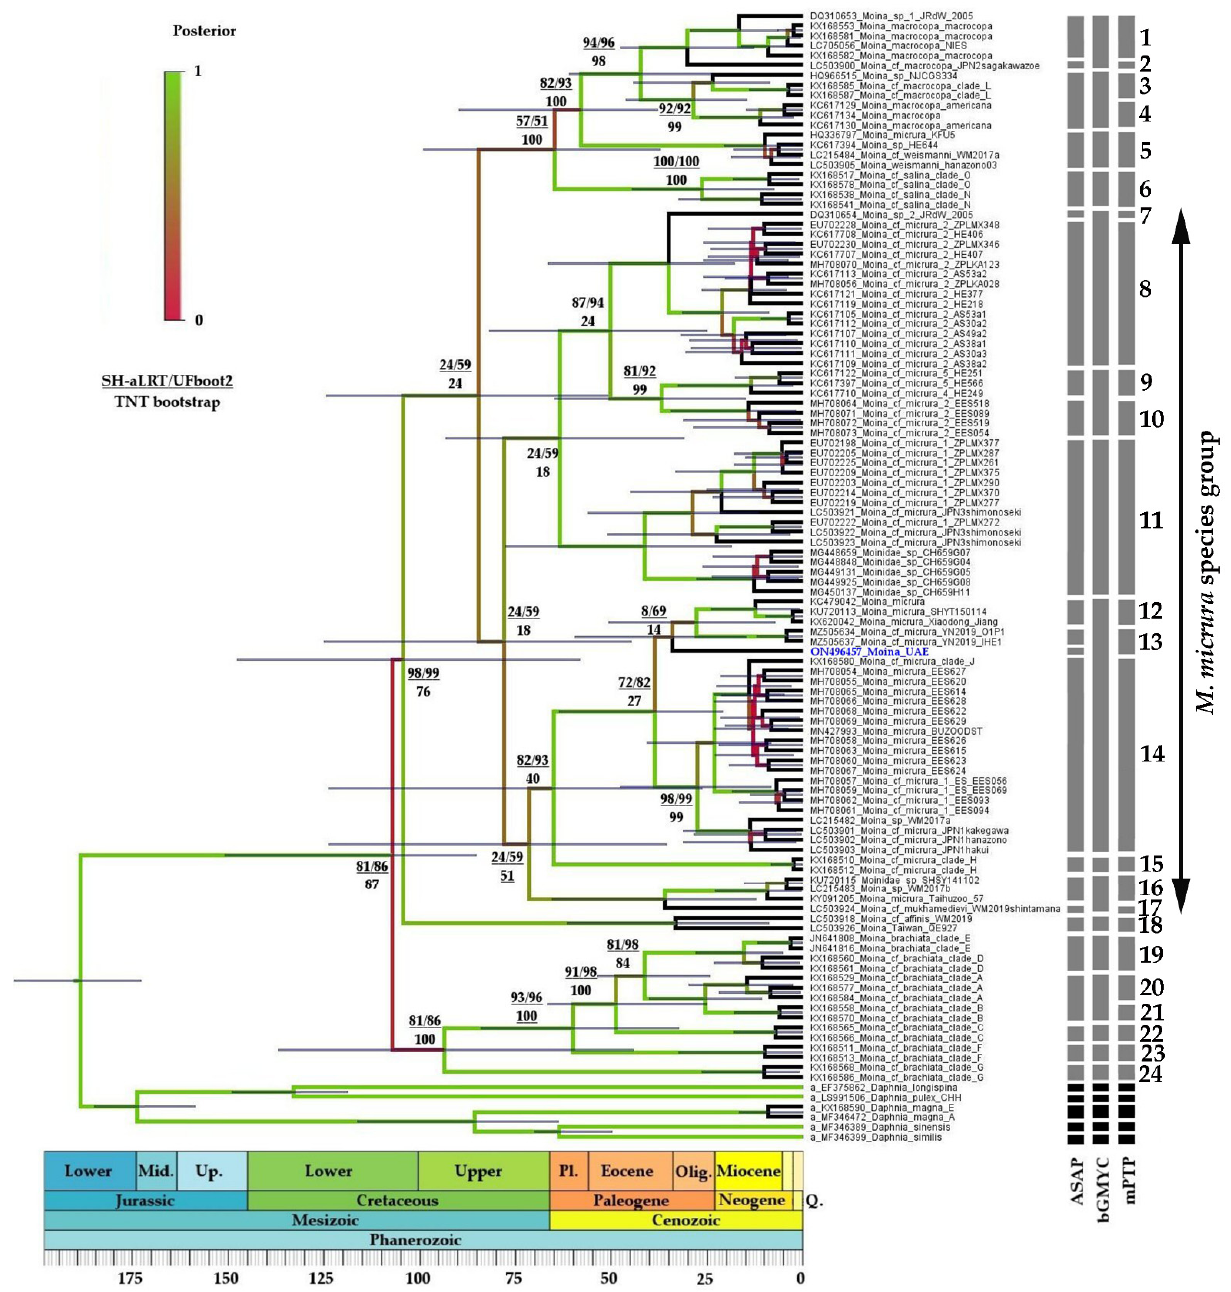
Figure 22. Phylogenetic ultrametric tree based on COI mitochondrial gene for Moina with relaxed molecular clock estimates based on fossil calibration points. Sequence from UAE is marked with blue colour. Prior probability of branches is coded by the colour gradient from red (low) to green (high). Node supports for key points are: value of the SH-aLRT for the first digit/value of UFboot2 (ML) for the second digit and standard (TNT) bootstrap value in the denominator. The bars depict the 95% highest probability density (HPD) interval of the estimated divergence times. Results of delimitation based on p -distance (ASAP), the Bayesian general coalescence model (bGMYC) and multi-rate Poisson tree processes (mPTP) are represented by grey bars on the right side.